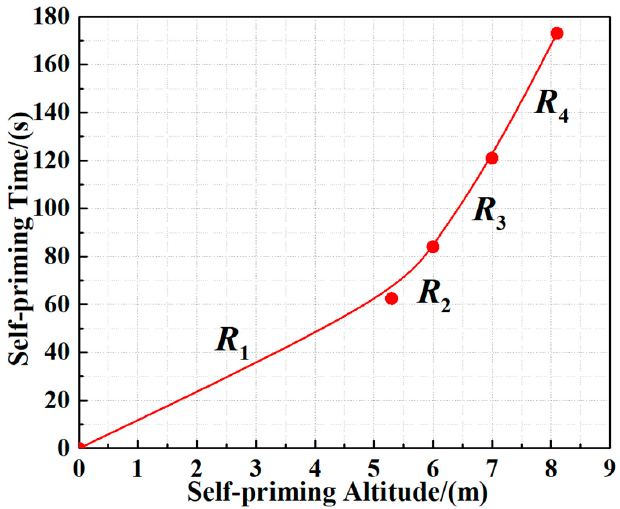
Figure 18. Self-priming time at different altitudes.